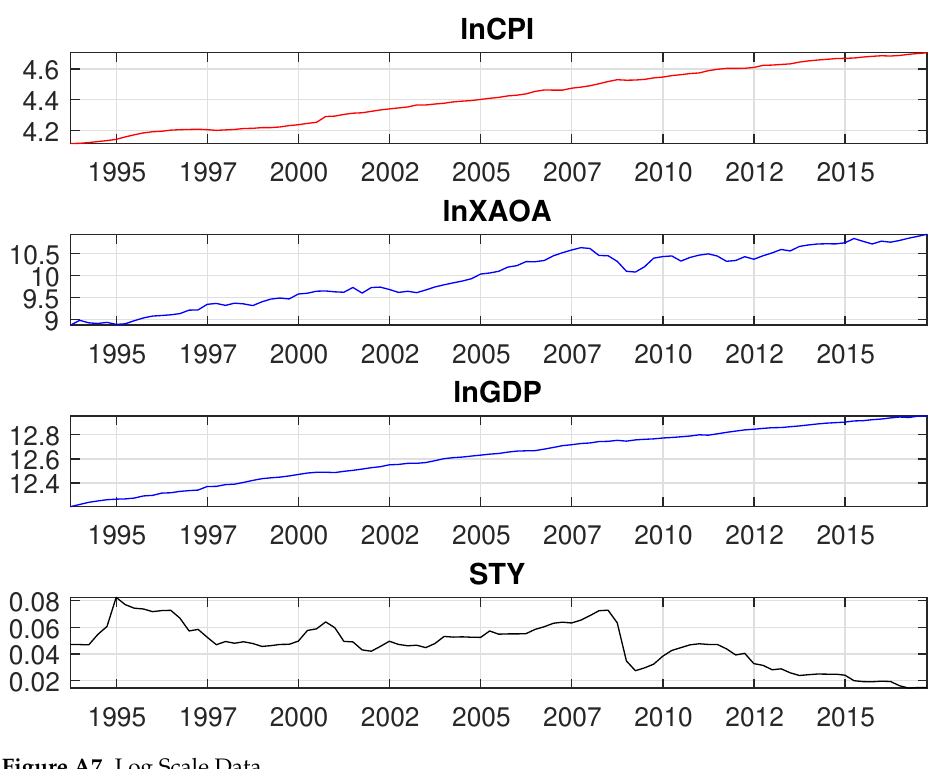
Figure A7. Log Scale Data.